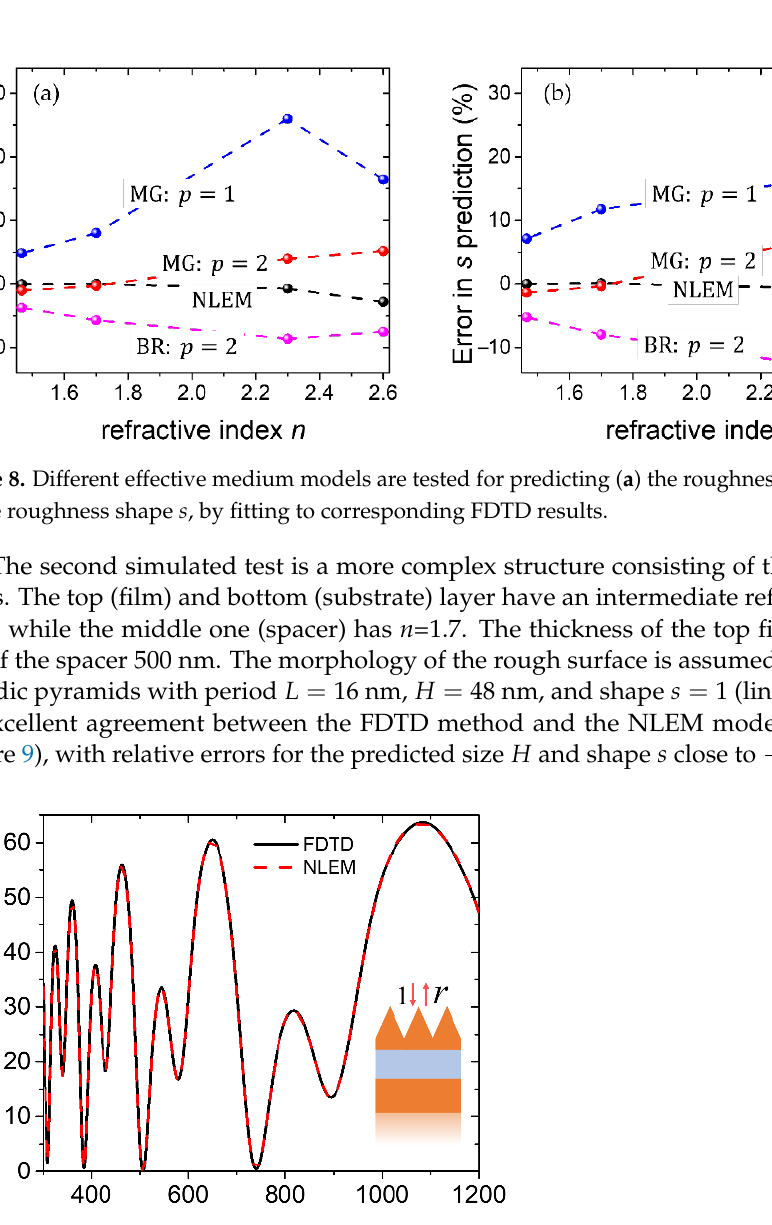
Figure 9. FDTD and NLEM reflectance for a system of three material layers with refractive indices 𝑛 = 3,1.7,3 showing excellent agreement.